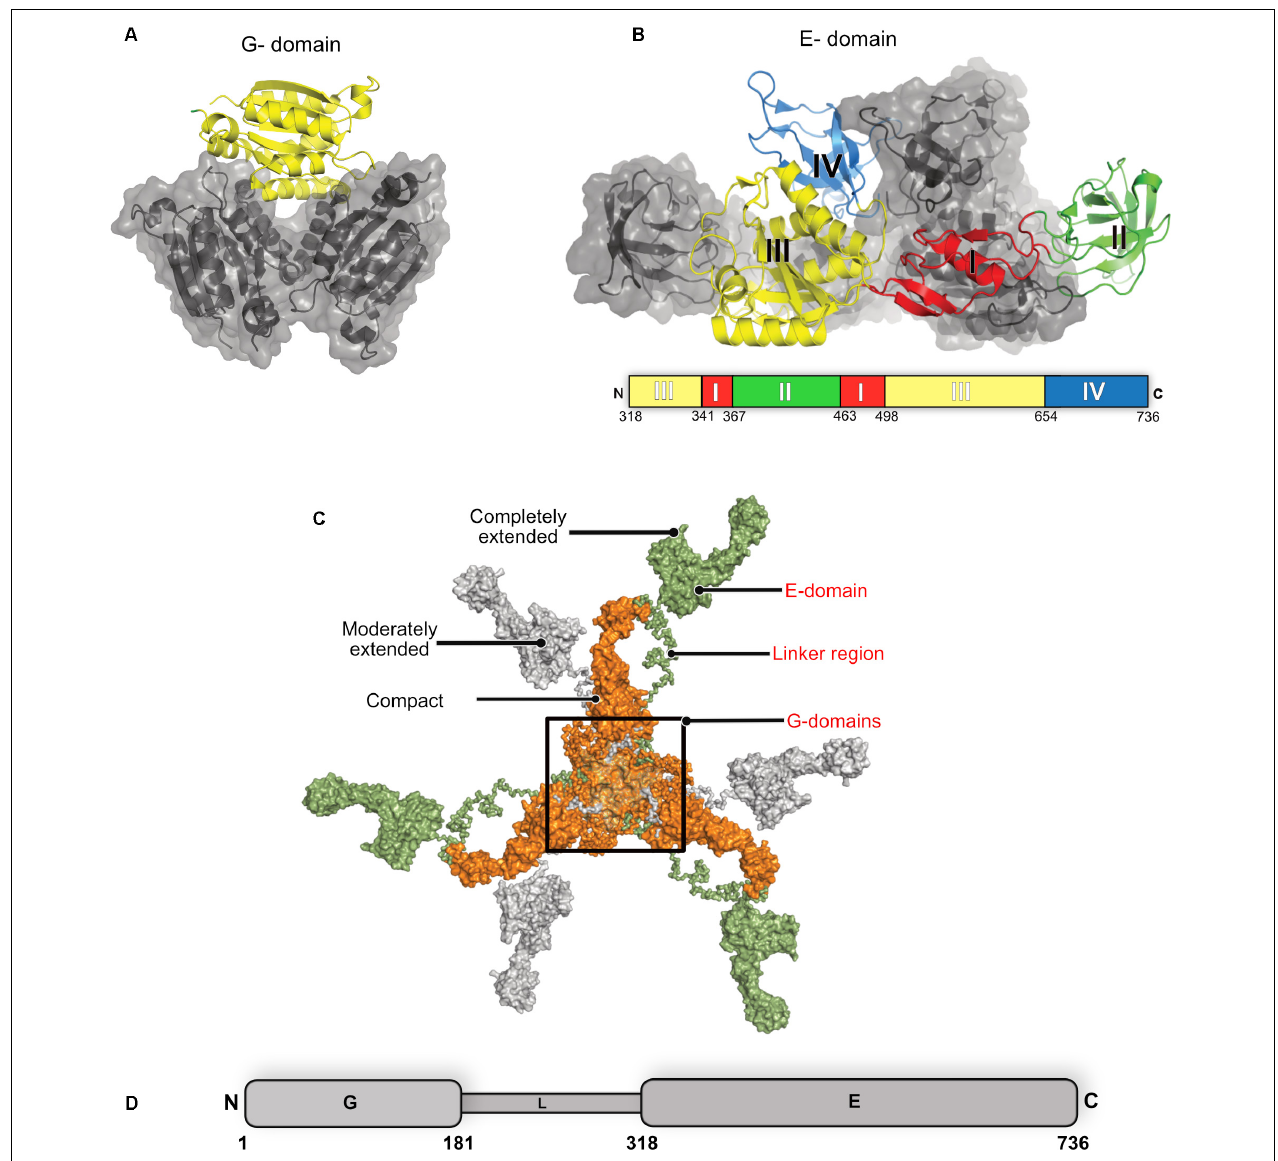
FIGURE 6 | Structure of gephyrin. (A) Crystal structure of the N-terminal GephG trimer where one monomer is shown in cartoon representation (yellow) and the other two in surface representation in gray (PDB: 1JLJ). (B) Crystal structure of the C-terminal GephE dimer with one monomer colored according to its four subdomains (border lining residues of each subdomain are shown in the schematic diagram below the crystal structure) and the other monomer in surface representation in gray (PDB: 5ERQ). (C) Surface view of the ensemble of models of the full-length gephyrin derived from SAXS studies, where the compact state of the protein is represented in orange, the moderately extended state in gray and the fully extended state in green. (D) Schematic representation of the domain architecture of